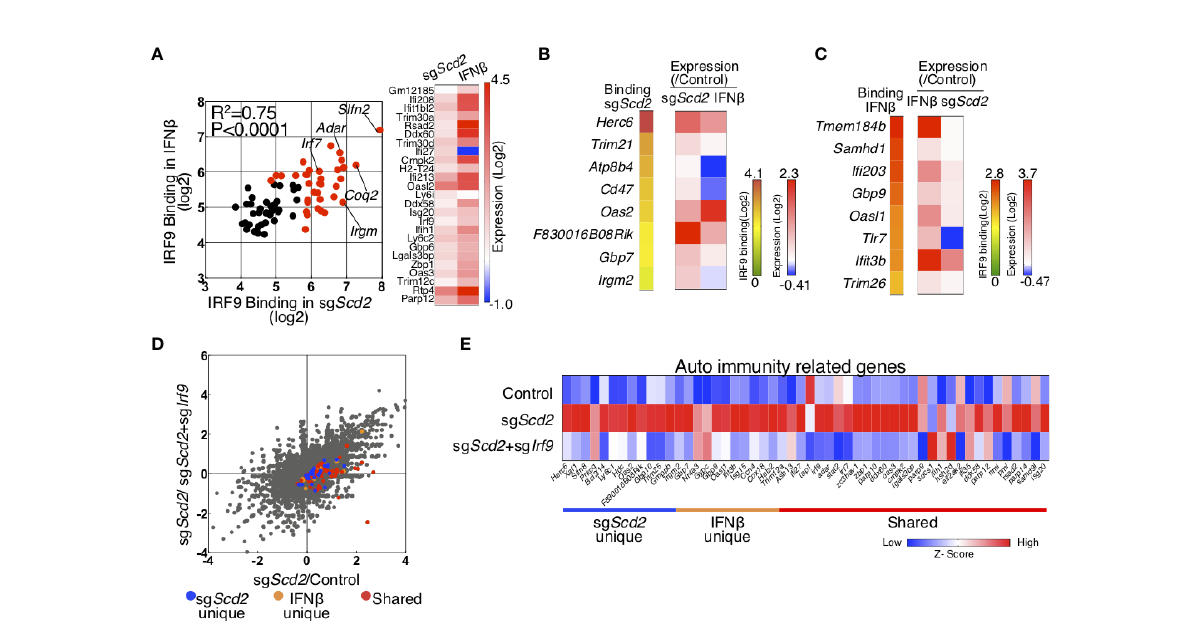
FIGURE 5 Integrated analysis of RNA-seq and IRF9 ChIP-seq was performed to investigate ISG transcriptome regulated by IRF9. (A) Scatter plots depicting IRF9 binding in sgScd2 Th1 cells (x axes) and IFN b -treated Th1 cells (y axes) for all shared IRF9-bound genes. Genes with signal intensities higher than 5.64 (Log2) are marked with red dots. A heat map shows 1.5-fold upregulated genes in sgScd2 Th1 cells. (B, C) A heat map shows normalized IRF9 ChIP-seq signal intensities relevant to Figure 4A and relative gene expression using qRT-PCR in sgScd2-unique (B) or IFN b - unique peaks (C) . (D) A dot plot of gene expression by RNA-sequencing relevant to Figure 1 compares in sgScd2 Th1 cells/control or sgScd2+ sgIrf9 Th1/control Th1 cells. The genes related to sgScd2-unique, IFN b -unique peaks or shared were marked with blue, orange or red dots, respectively. (E) A heat map shows relative expression of auto immunity related genes in control, sgScd2 and sgScd2/sgIrf9 Th1 cells. Three technical replicates were performed with quantitative RT-PCR (B, C) . Three experiments were performed and showed similar